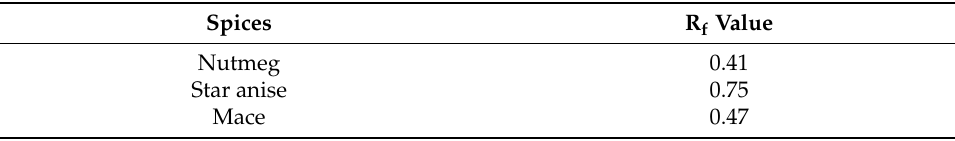
Table 6. R f values of nutmeg, star anise, and mace by TLC.